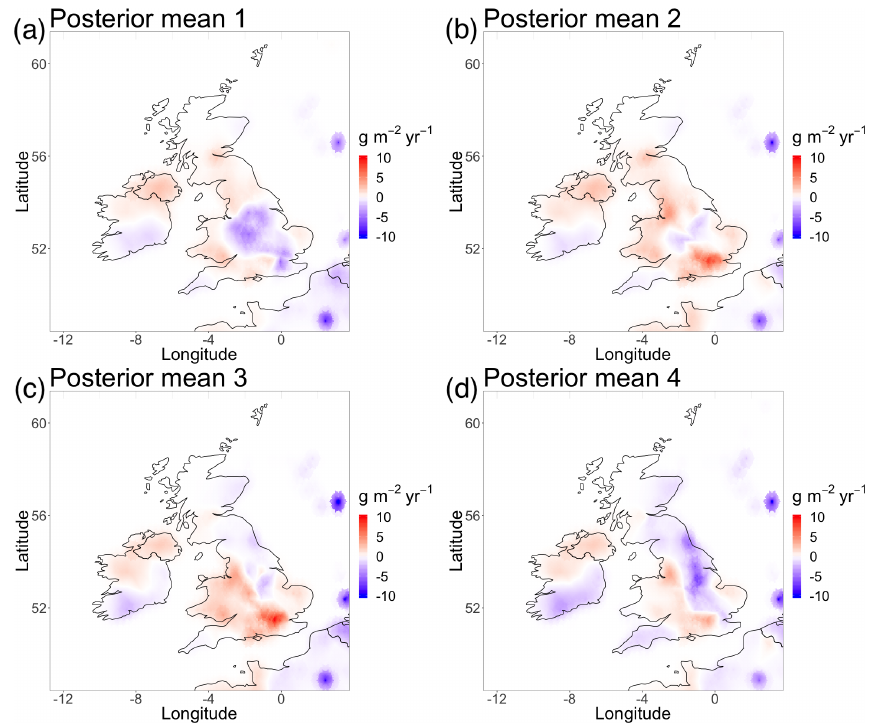
Figure 4. The inferred mean deviation of emissions from the prior mean for (a) the first time period, (b) the second time period, (c) the third time period and (d) the fourth time period.